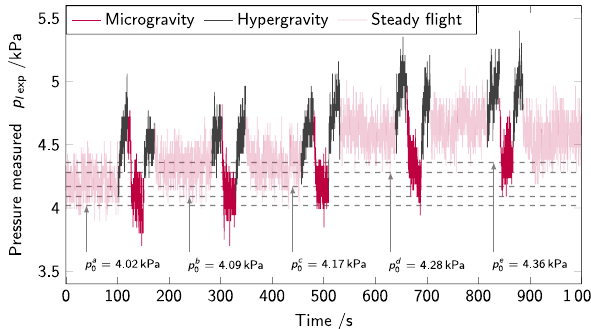
granular samples generally undergo a slight positive accelera- tion along the z -axis at the initial instant of each parabola, which is expected to counteract the compaction caused by hypergravity.